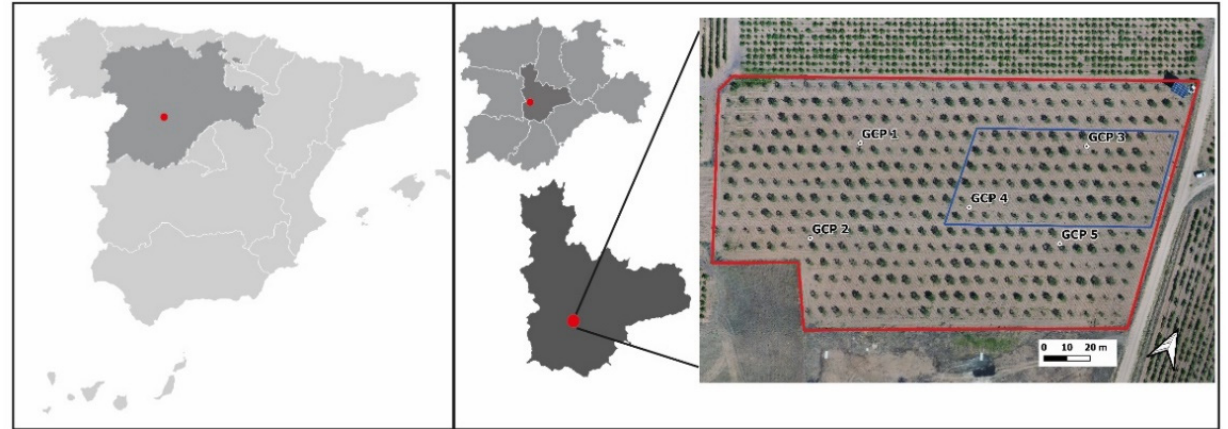
Figure 1. Location of the pistachio orchard in the ‘Castilla y León’ region, Spain. Coordinates: X: 341450.3, Y: 4589731.8; ETRS89/UTM zone 30N. Red polygon: UAV flight area. Blue polygon: area where the ground-truth measures were taken.